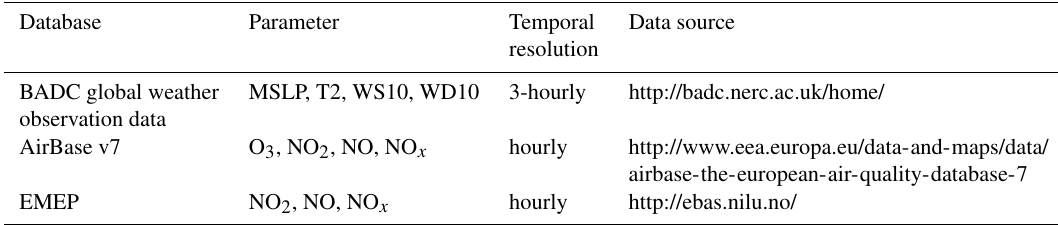
Table 3. Observational datasets used for model evaluation.